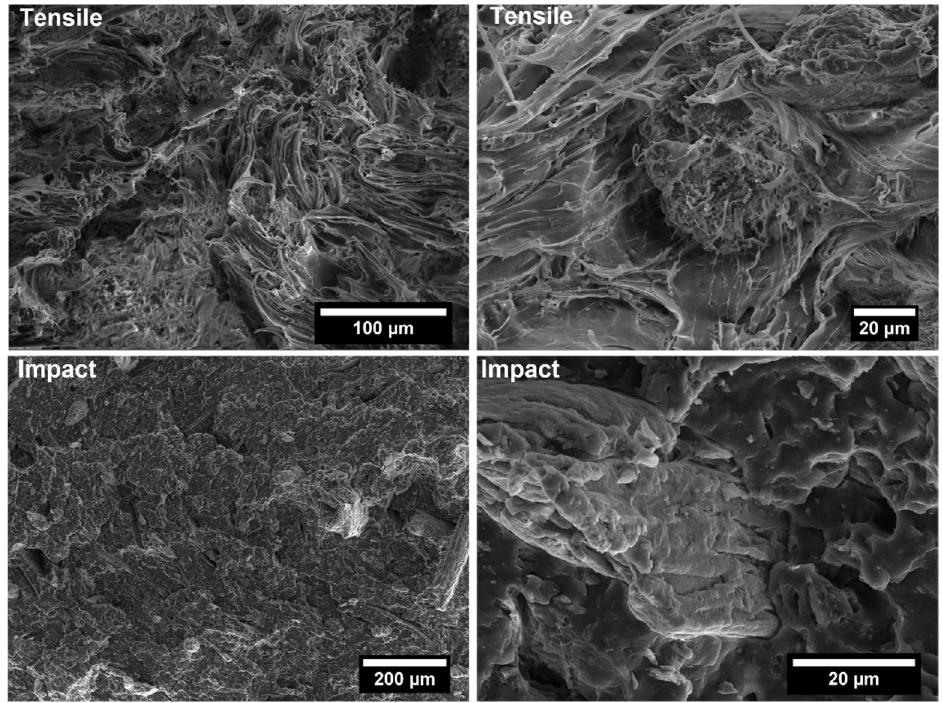
Figure 13. SEM micrographs of PP-based biocomposites with 30 wt.% of palm leaf fillers without coupling agent after tensile and Charpy impact tests.